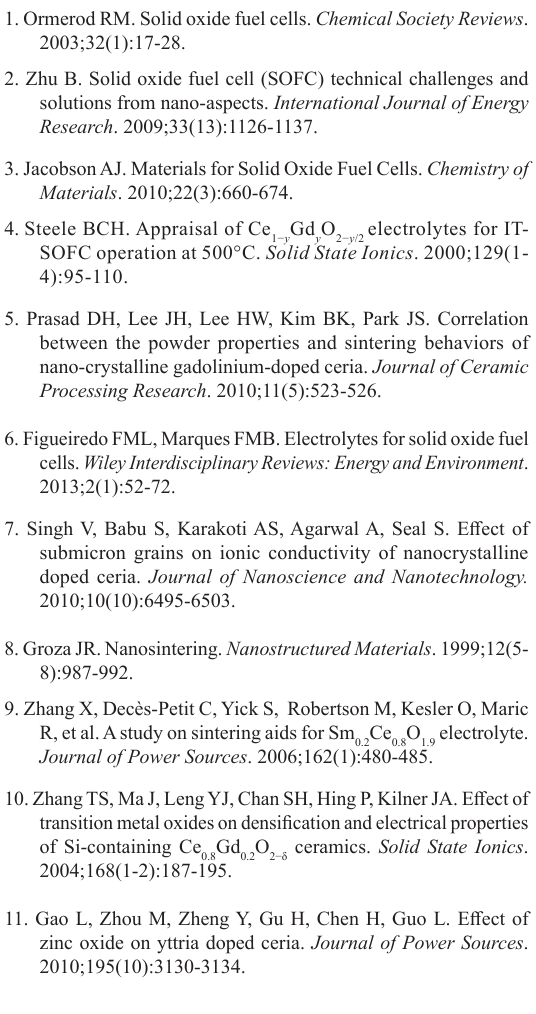
Table 3: Total conductivity (σ